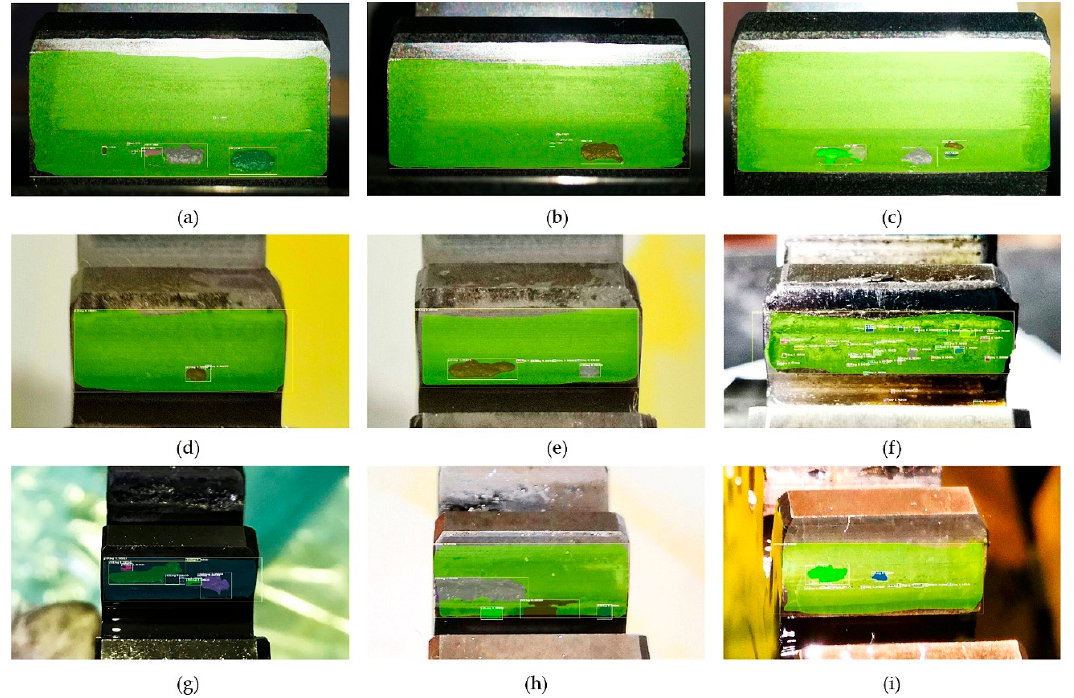
Figure 11. Detection results obtained under different illumination conditions and shooting angles. (a) α =15° I; (b) α =15° II; (c) α =15° III; (d) α =45° I; (e) α =45° II; (f) α =45° III; (g) α =75° I; (h) α =75° II; (i) α =75° III.